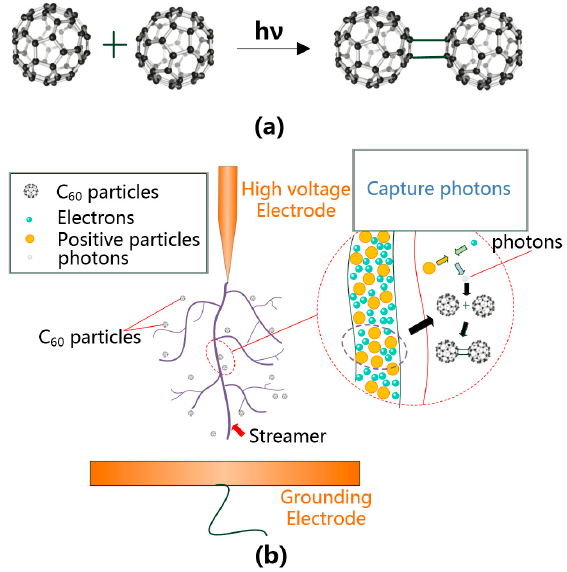
Figure 18. ( a ) Two C 60 molecules absorb photons and form dimer, ( b ) C 60 absorbs photons in the streamer through photopolymerization reaction.